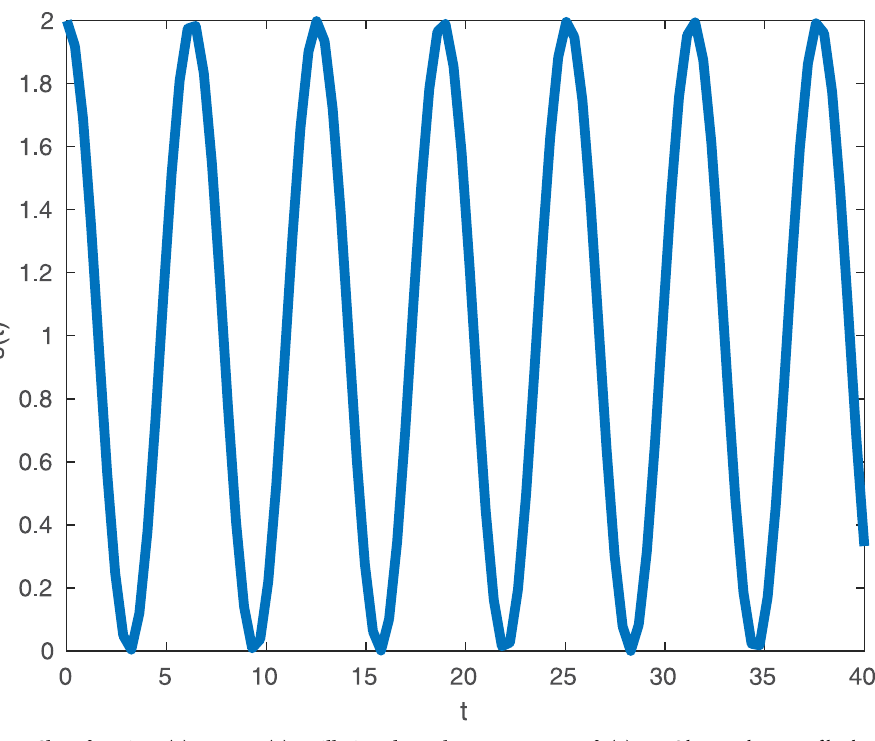
Fig 1. Sleep function s ( ρ )= 1 + cos( ρ ) oscillating about the constant case of s ( ρ )= 1. Observe the cost of higher activity at some times is lower activity at others.